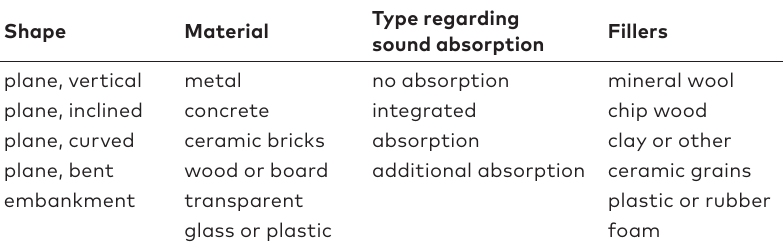
Table 1. Classification of various noise barriers (Yoon & Pyo,